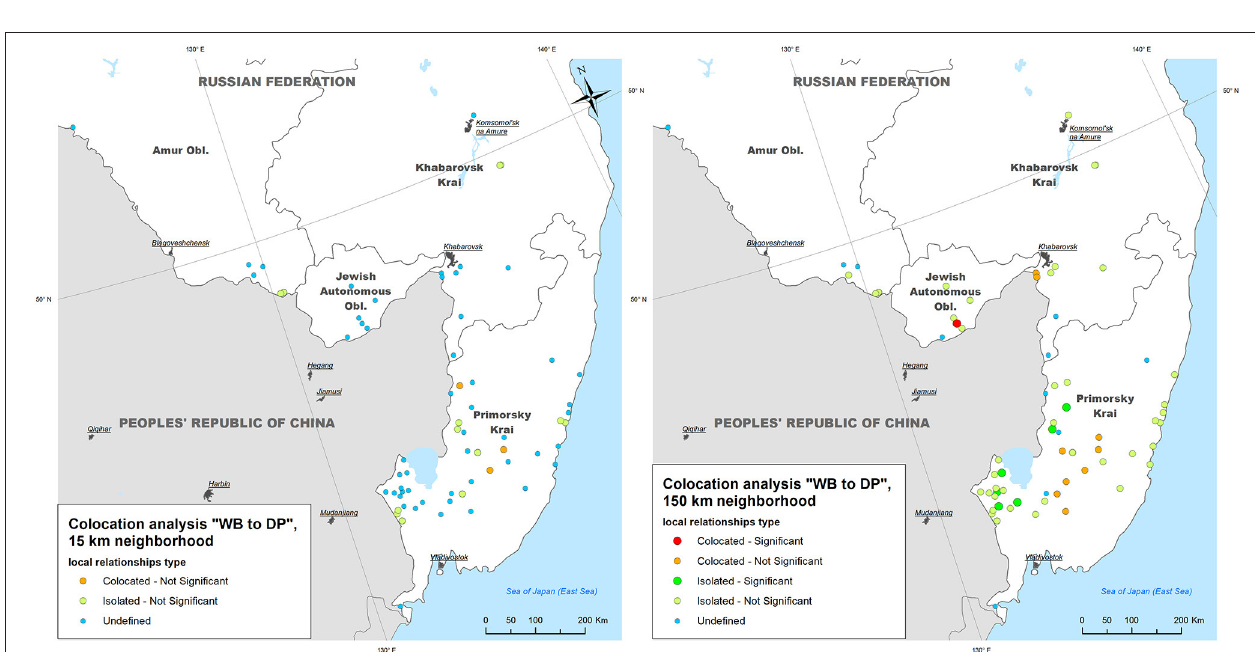
FIGURE 5 | The results of local colocation analysis of ASF outbreaks in wild boar (WB) and domestic pigs (DP). (Left) With 15km as a neighboring distance; (Right) with 150km as neighboring distance.